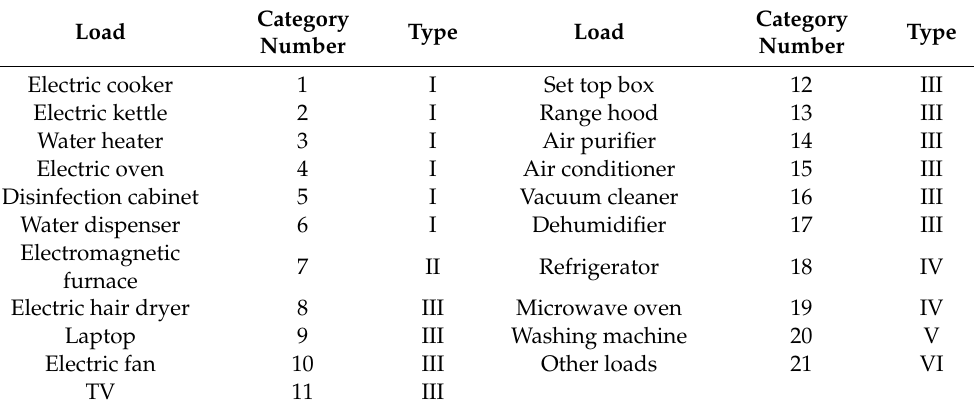
Table 2. Electrical appliances classification label and pre-classification.